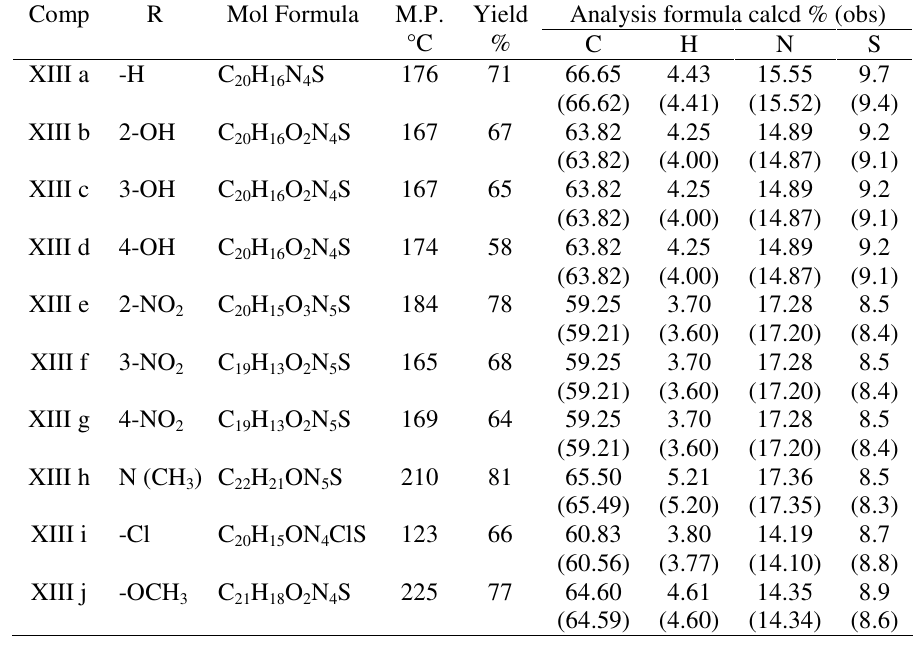
Table 4 . Characterization data of newly synthesized compounds (XIII a-j)